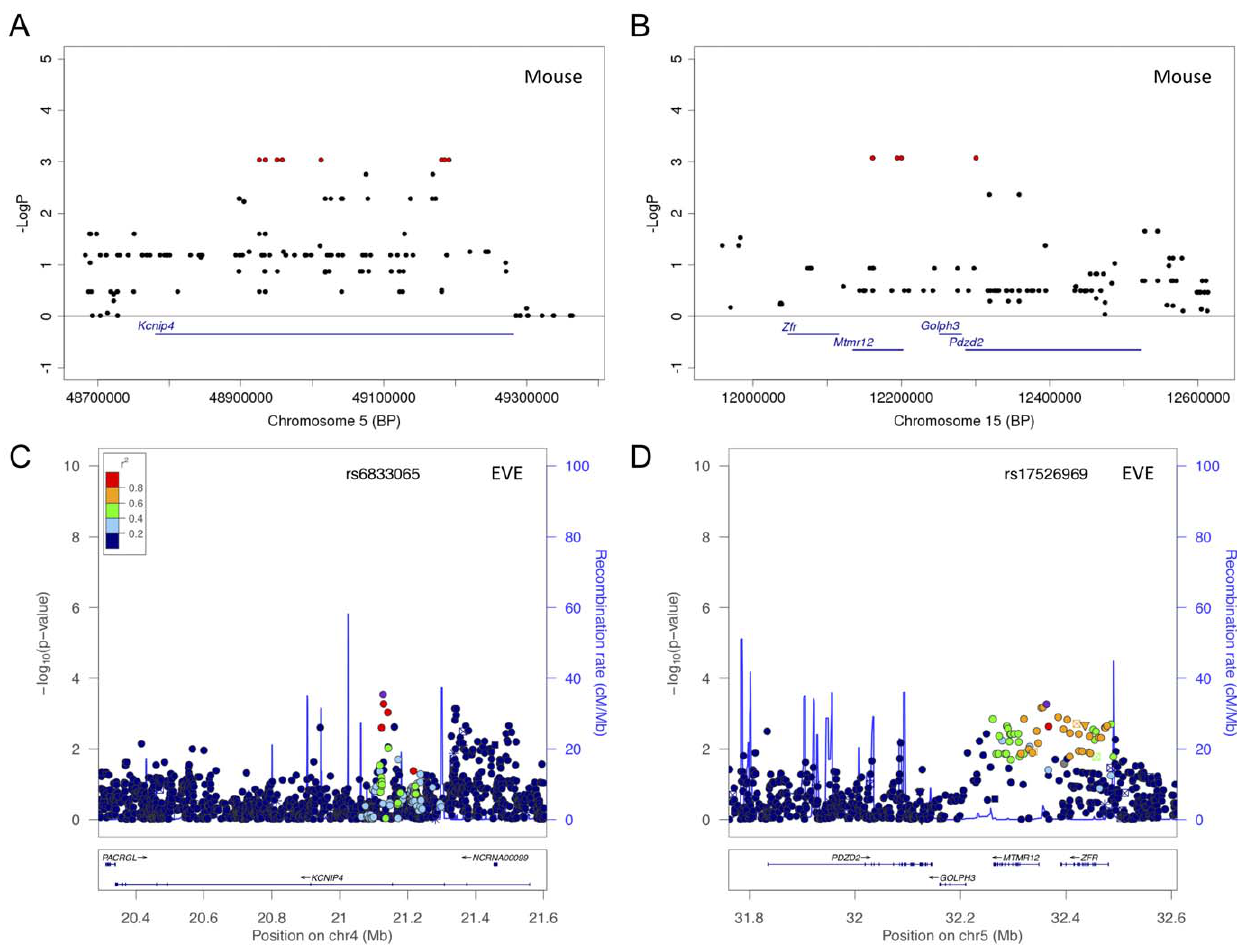
Figure 4. Top regions of association in mouse and human. Mouse plots near (A) Kcnip4 and (B) Pdzd2/Golph3/Mtmr12/Zfr contain –Log 10 of EMMA p-values vs. position along the corresponding mouse chromosome. Corresponding human homologous plots near (C) KCNIP4 and (D) PDZD2/ GOLPH3/MTMR12/ZFR . The x-axis denotes position along corresponding human chromosome, while the y-axis denotes –Log 10 (P) corresponding to EVE p-values for the combined sample GWAS (C) or European American GWAS (D). LD between the SNPs with the lowest P-value to other SNPs in the human plots are denoted in colors and were computed according to HapMap Phase 2 CEU data using LocusZoom [55].